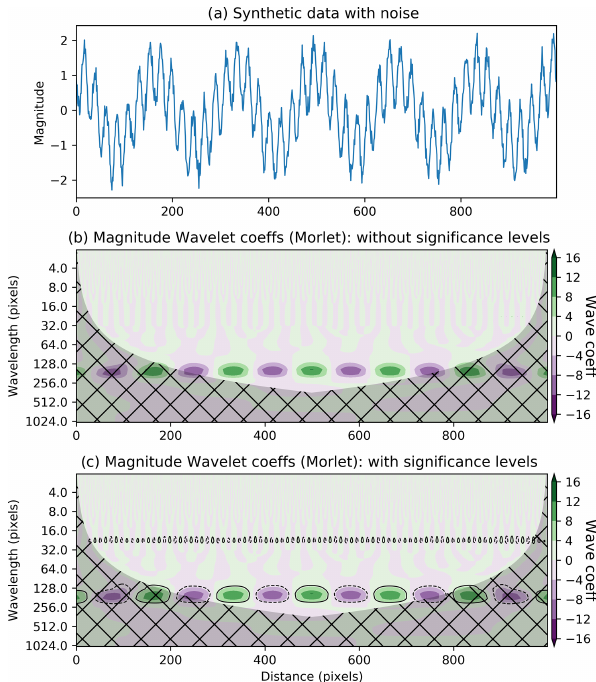
Figure A3. Example of why a significance test is needed. Panel (a) is a 1D synthetic, noisy signal made of two waves of different wave- lengths. Panels (b) and (c) present the 1D wavelet transformation of (a) with a 1D Morlet wavelet. In (b) , the result is only visualised, while in (c) the significance test is also visualised. In both, the hatched area contains edge effects and is delimited by a 1D cone of influence. The contouring in (c) shows domains that are within the 95% confidence level of not being white noise. The contours high- light values that are both positively and negatively larger than the white noise model. The takeaway message is that the significance test is needed to accurately identify regions of “real